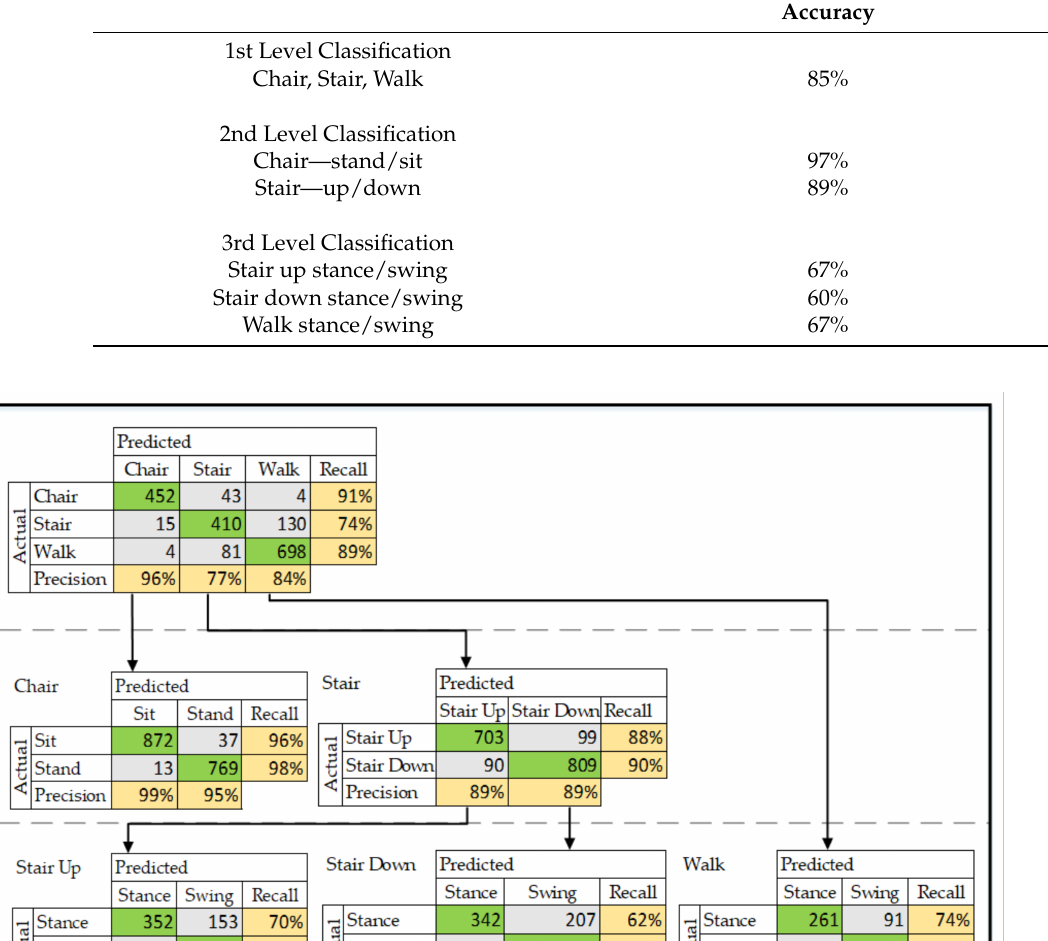
Table 3. Accuracy of CNN models using leave-one-out cross-validation for each level of classification.